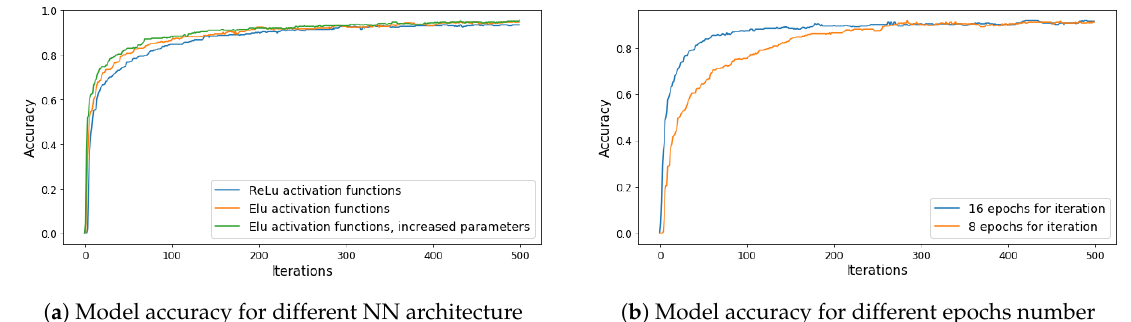
Figure 10. Neural network accuracy.